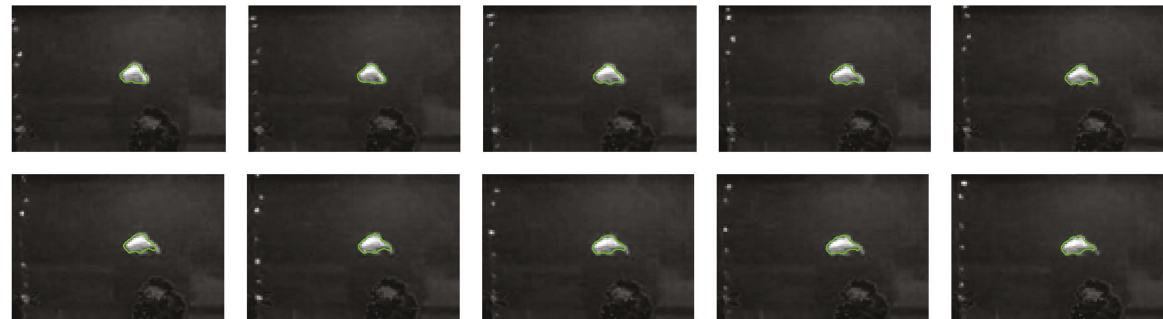
Figure 8: The results of segmentation with proposed block evolution